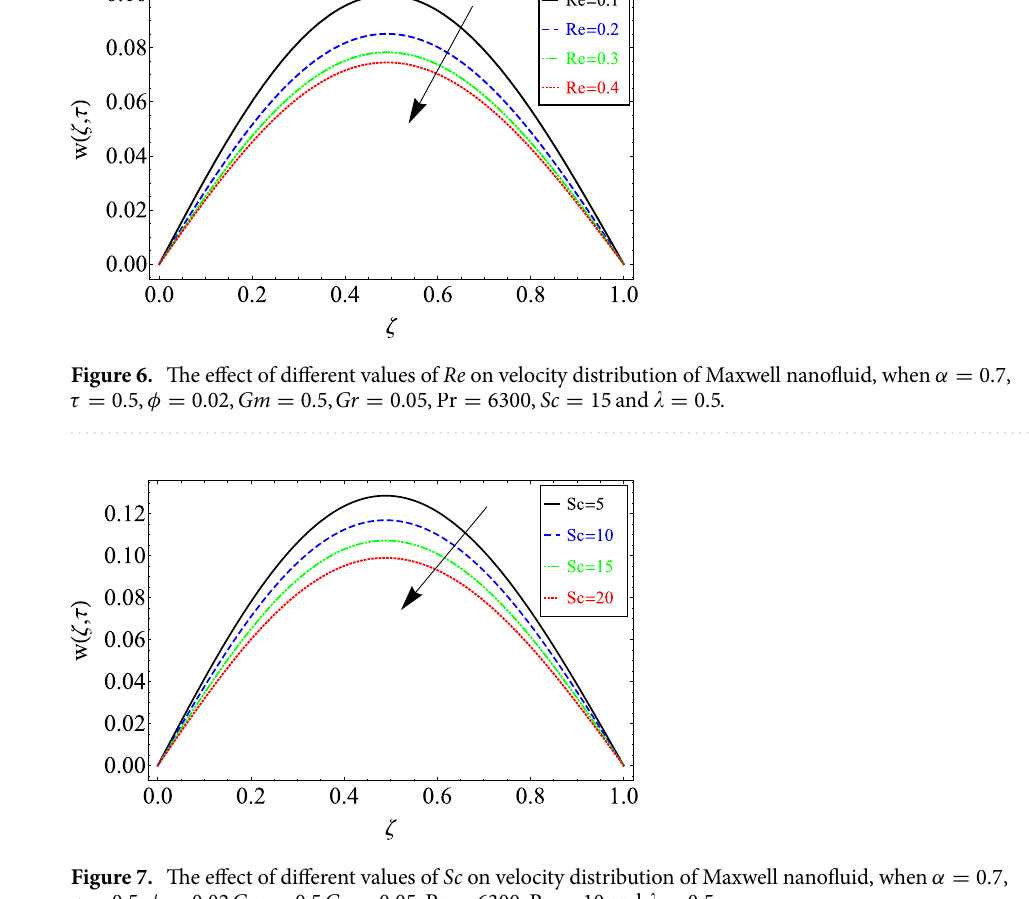
Figure 7. The effect of different values of Sc on velocity distribution of Maxwell nanofluid, when α = 0.7 , τ = 0.5 , φ = 0.02 , Gm = 0.5, Gr = 0.05 , Pr = 6300 , Re = 10 and (cid:31) = 0.5